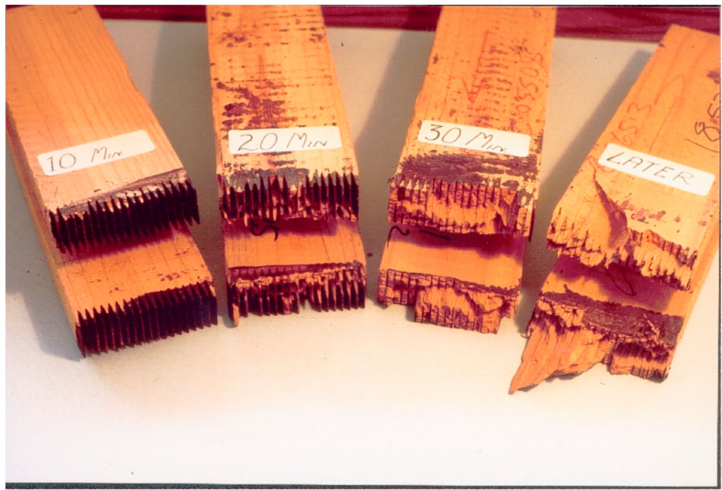
Figure 4. Development of strength visualized through the rapid increase in percentage wood failure of tannin-based fast-setting “honeymoon” separate application cold-setting adhesives for glulam and